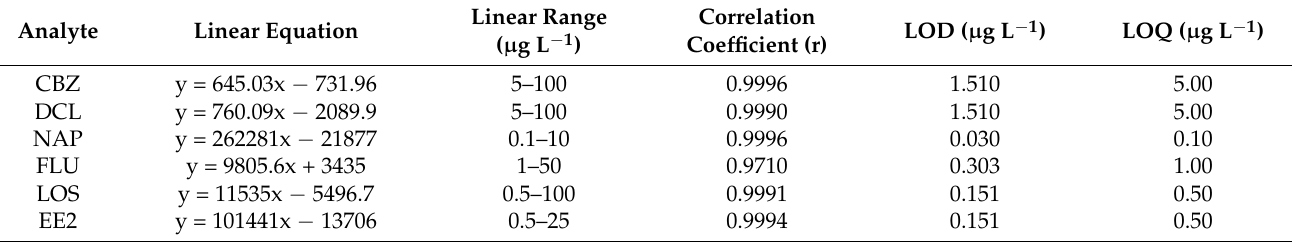
Table 2. Linear equation, linear range, correlation coefficients, limits of detection, and quantification obtained for the pharmaceutical compounds in hospital wastewater using the fully optimized Si3Py + Cl − -DPX-based procedure.